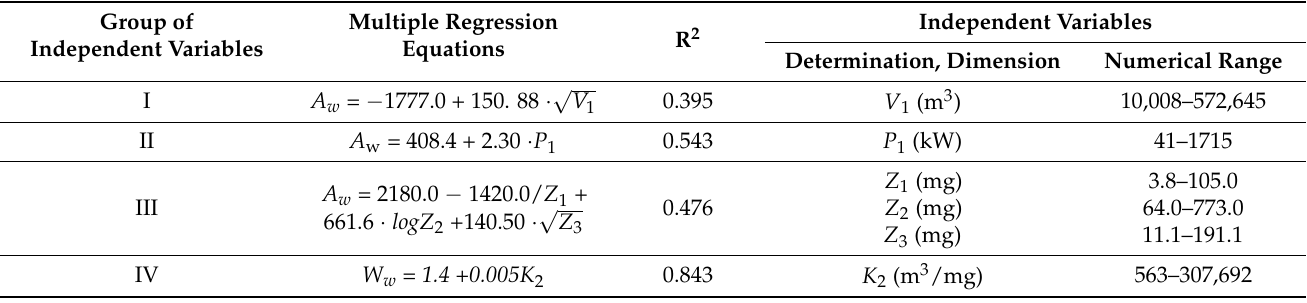
Table 3. Factors affecting water consumption variability in the fruit and vegetable industry plants. Group of Independent